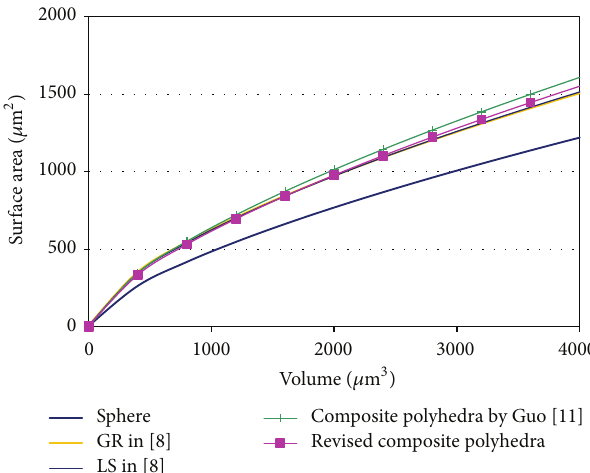
Figure 3: 𝑆 - 𝑉 curves of crushed rock types (GR and LS), of composite polyhedra and of the